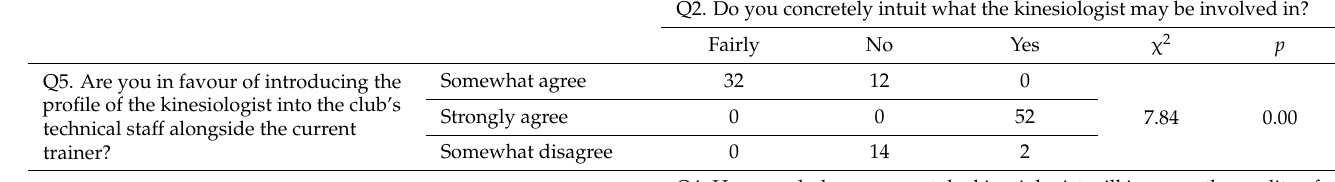
Table 6. Differences in perception found among